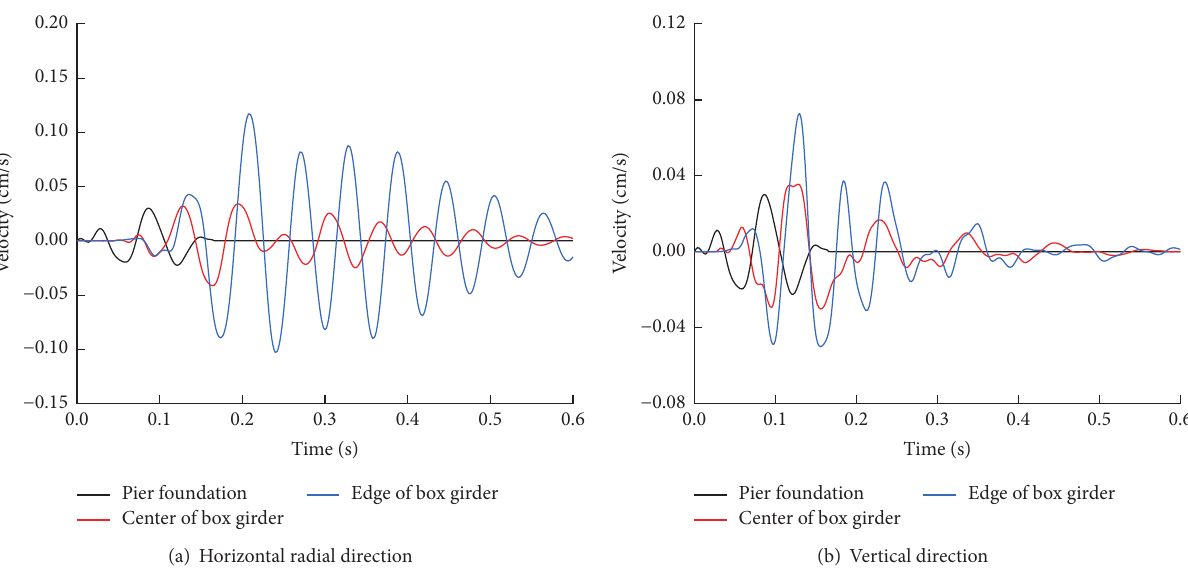
Figure 12: Vibration wave curves of the typical nodes under the load of 0.03 cm/s.